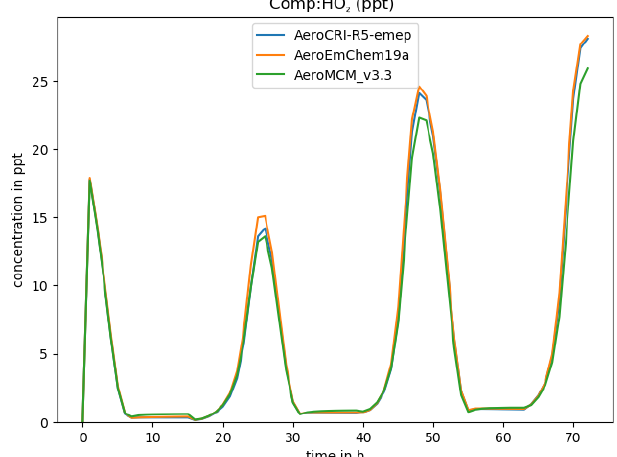
Figure 3. Example of comparison of three chemical schemes, pro- duced for HO2 with the boxplots.py